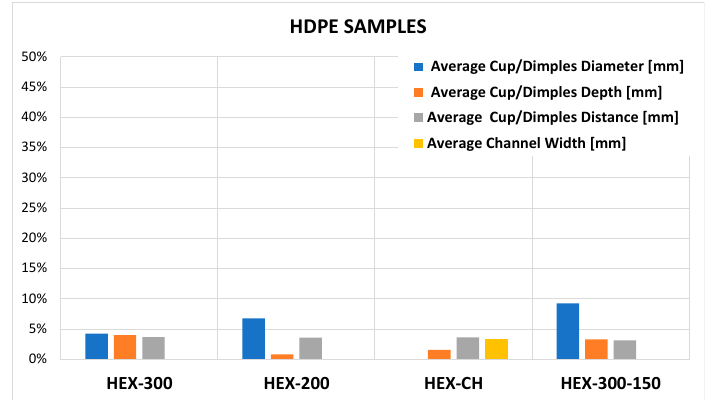
Figure 12. Percentage errors for HDPE samples.